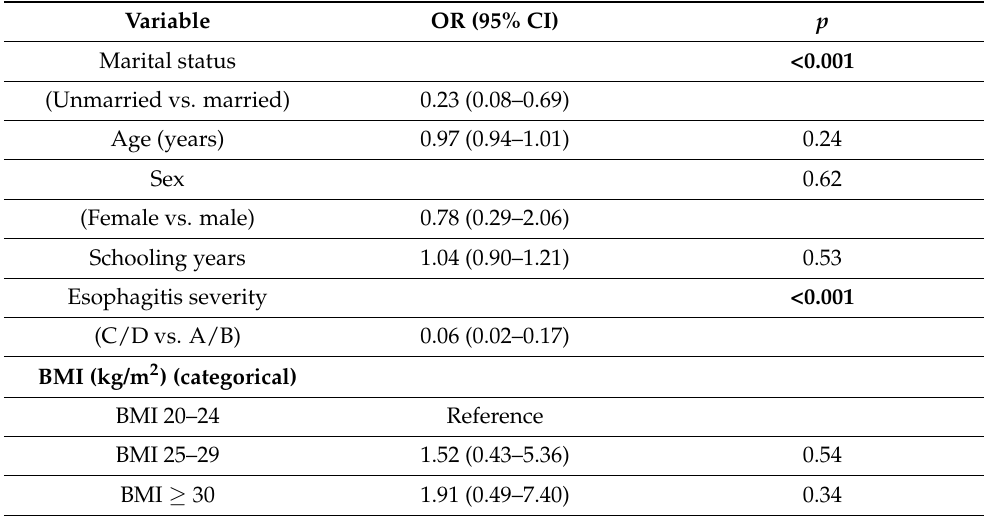
Table 4. Multivariable logistic regression model for factors associated with adherence to treatment and esophagitis severity among GERD